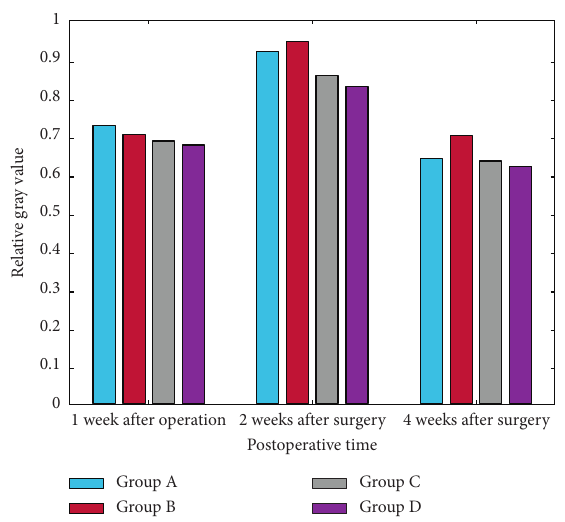
Figure 2: Histogram of VEGF expression at 1, 2, and 4 weeks after surgery.